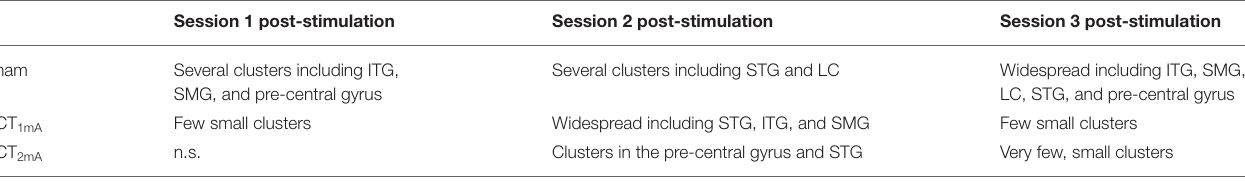
TABLE 3 | Summarized findings highlighting regions with significantly decreased CBF resulting from the pairwise comparisons of each post-stimulation measurement with